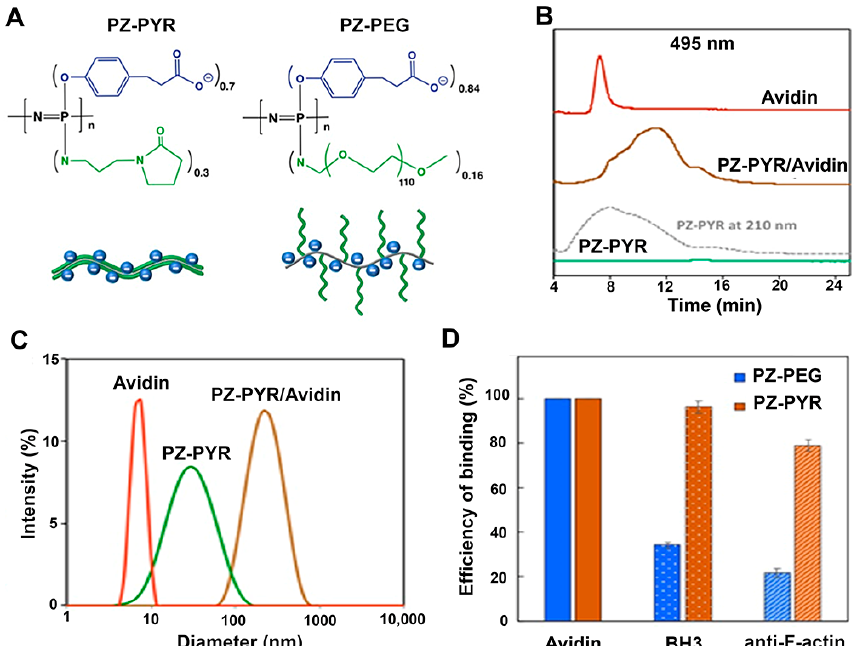
Figure 1. Schematics and characterization of polyphosphazenes (PZ)/protein complexes. ( A ) Chemical structures of PZ-PYR and PZ-PEG polymers and their schematic presentations. ( B ) Representative AF4 profiles of FITC-avidin, PZ-PYR, and PZ-PYR/FITC-avidin as detected at 495 nm (PZ-PYR profile at 210 nm detection is shown for comparison purposes). ( C ) Dynamic light scattering profiles of FITC-avidin, PZ-PYR, and PZ-PYR/FITC-avidin (25 mM phosphate buffer, pH 7.4). ( D ) Efficiency of protein or peptide binding to PZ-PEG and PZ-PYR expressed as a percent of bound molecules of their total amount for FITC-avidin, Bax-BH3 peptide, and anti-F-actin antibody (25 mM phosphate buffer, pH 7.4).